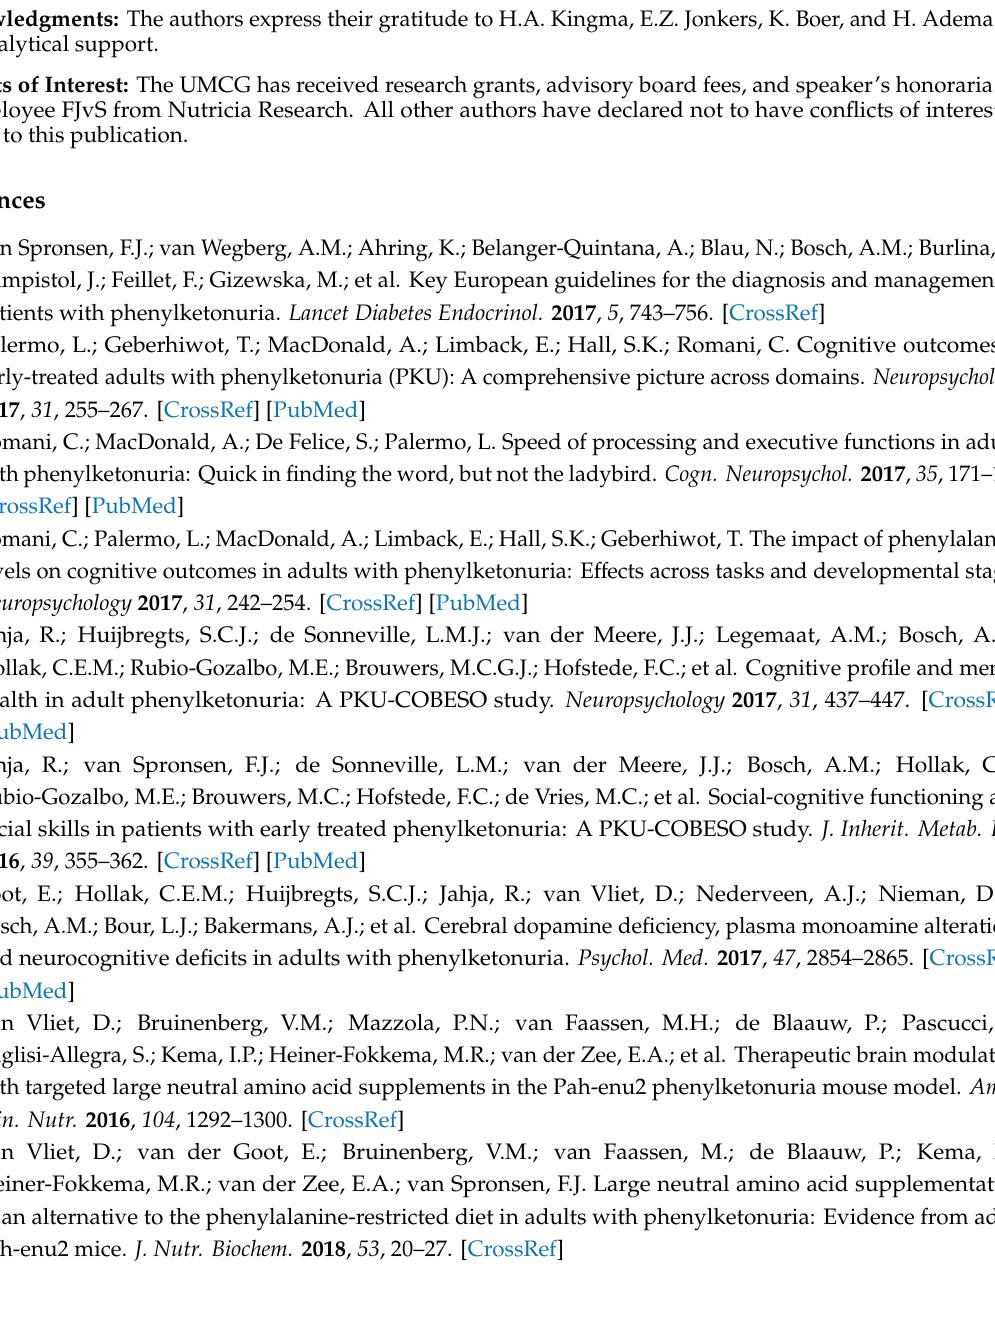
Figure S1: Mean weekly food intake per body weight in male (A) and female (B) WT and PKU mice on various diets during the six weeks of dietary treatment, Figure S2: Brain serotonin (A,C) and norepinephrine (B,D) concentrations in relation to plasma (A,B) and brain (C,D) phenylalanine concentrations in PKU mice on